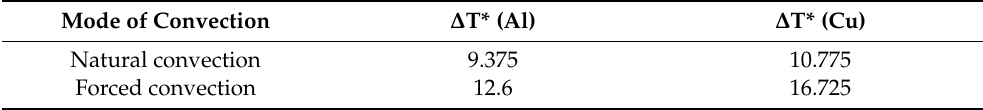
Table 3. The temperature difference between the different metals in different ways ∆ T*. Mode of Convection ∆ T* (Al) ∆ T* (Cu) Natural convection 9.375 10.775 Forced convection 12.6